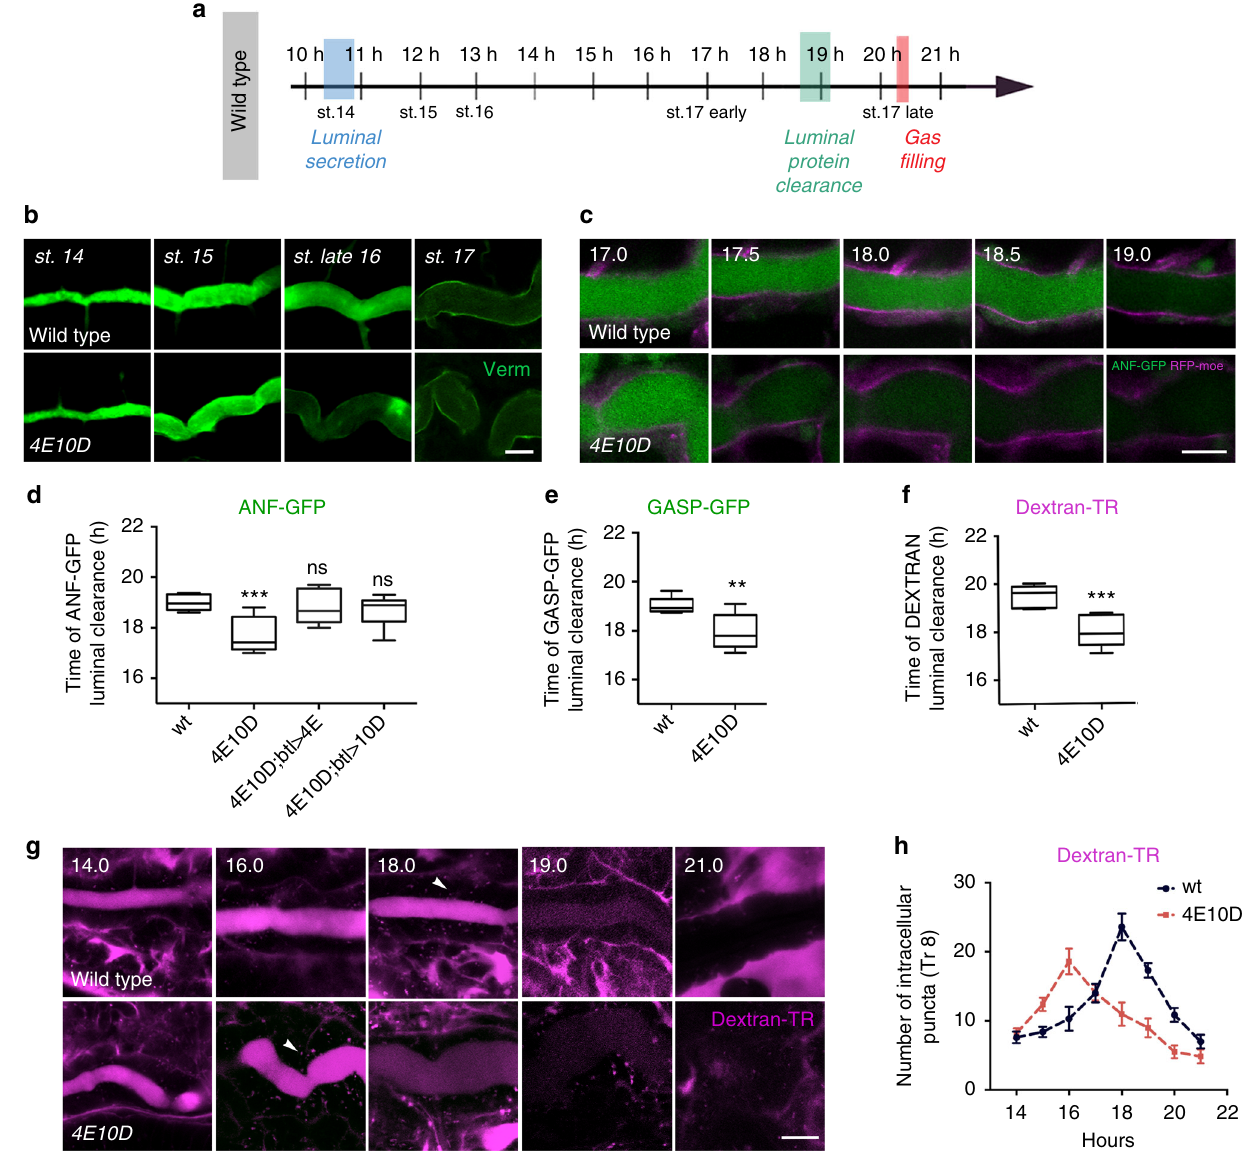
Fig. 1 Ptp10D and Ptp4E control the precise timing of luminal protein clearance in a cell autonomous manner. a Schematic representation of the Drosophila airway maturation. The x axis depicts the time of embryo development in hours after egg laying (AEL) and the corresponding embryonic stages. The airway maturation steps luminal secretion, luminal protein clearance and gas fi lling are indicated. b Confocal images showing the tracheal dorsal trunk (DT) of stage 14 – 17 wild-type and Ptp4EPtp10D ( 4E10D ) mutant embryos stained for the luminal protein Verm (green). c Confocal sections showing the tracheal DT of living wild-type and Ptp4EPtp10D mutant embryos expressing btl>ANF-GFP (green) and RFP-moesin (magenta). d Plots showing the average time (hours) of luminal ANF-GFP clearance in wild-type ( n = 36), Ptp4EPtp10D ( n = 43), Ptp4EPtp10D ; btl>ptp4E-GFP ( n = 28) and Ptp4EPtp10D ; btl>ptp10D ( n = 33) embryos, expressing btl>ANF-GFP . e , f Plots showing the average time (hours) of luminal btl>GASP-GFP ( e ) or Dextran-Texas Red (Dextran-TR, 10 kDa) clearance ( f ) in wild-type (GASP-GFP, n = 32; Dextran-TR, n = 18) and Ptp4EPtp10D mutants (GASP-GFP n = 36; Dextran-TR, n = 30). The boxplots ( d – f ) show the median (horizontal line) and the data range from 25th to 75th percentile. Bars present maxima and minima values. ** P < 0.01. *** P < 0.0045. ns not signi fi cant ( P > 0.05). Data collected from fi ve independent experiments. Unpaired two tailed t test ( d – f ). g Confocal frames from live imaging showing the Dextran-TR luminal clearance in wild-type and Ptp4EPtp10D mutant embryos. Note that the premature luminal Dextran-TR clearance in Ptp4EPtp10D mutants is associated with earlier increase of intracellular puncta (16 h AEL) compared to wild type (18 h AEL) (arrowheads). h Graph representing the average number of intracellular Dextran-TR puncta in wild-type ( n = 19) and Ptp4EPtp10D mutants ( n = 30) during tracheal maturation. Data in each time point represent means from at least three independent experiments. Error bars represent the standard error of the means (s.e.m.). The time points c – h represent hours AEL. Scale bars, 10 μ m YRab11 or YRab1 (Supplementary Fig. 2a, b). This indicates that dual GFP-mCherry reporter for Ref(2)P, the Drosophila p62 Ptp10D and likely also Ptp4E are found in endocytic compart- orthologue 31 . This reporter relies on the difference in fl uores- cence stability between mCherry and GFP in acidic pH 32 . We ments. To investigate endosomal traf fi c progression in the Ptp4EPtp10D mutant airways, we labelled ubiquitinated proteins detected a relative increase in mCherry fl uorescence and a destined for autophagosomal or lysosomal degradation with the concomitant decrease in GFP signal of Ptp4EPtp10D tracheal cells NATURE COMMUNICATIONS| (2019) 10:2193